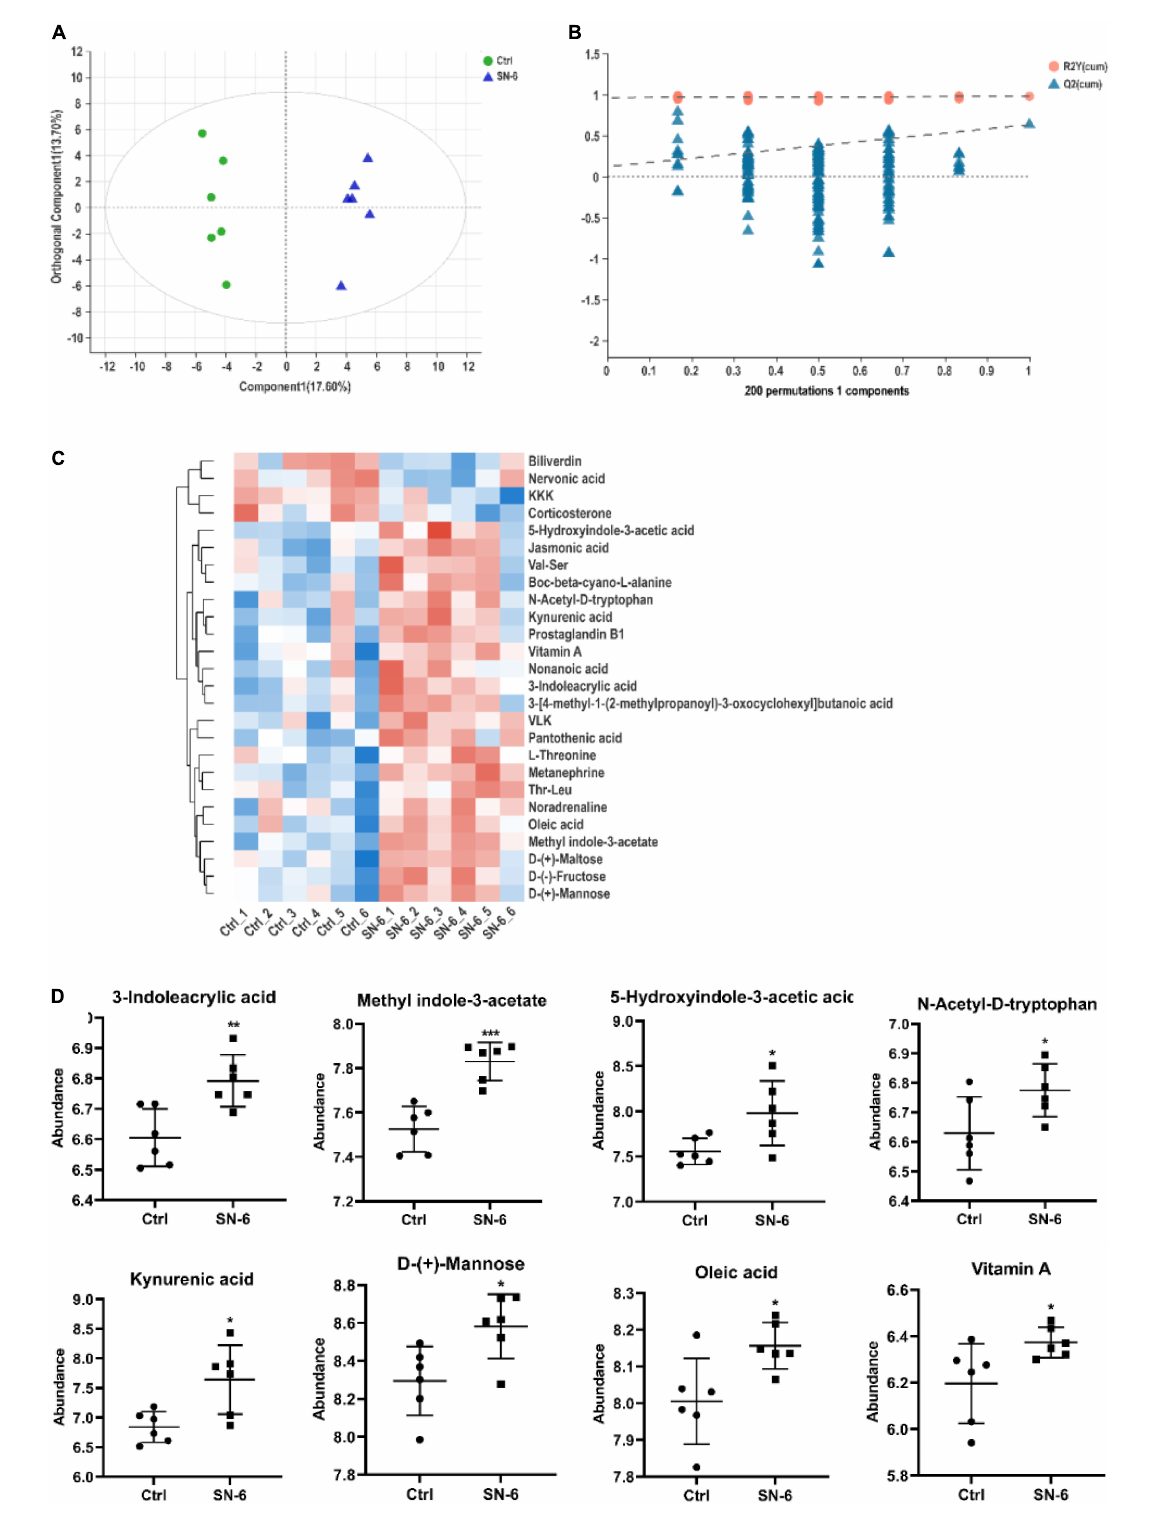
FIGURE5 Effects of SN-6 on the fecal metabolism of Simmental. (A) The orthogonal projection to latent structures discriminant analysis (OPLS-DA) score plot between the control and SN-6 groups. (B) Two hundred times permutations of OPLS-DA plot between the control and SN-6 groups. (C) Heatmap overview of 26 differential metabolites in feces throughout control and SN-6 groups. (D) Effect of SN-6 on the abundance of potential metabolites in fecal samples. Data are shown as mean ± SD ( n = 6). * p < 0.05, ** p < 0.01, *** p <